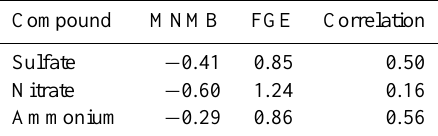
Table 8. Statistics of daily observation at the Canadian station (CA0008R) located east of Lake Superios against the RACMSIA simulation. The parameter sulfate corresponds to total sulfate and the modelled field takes into account a part of sulfate in sea